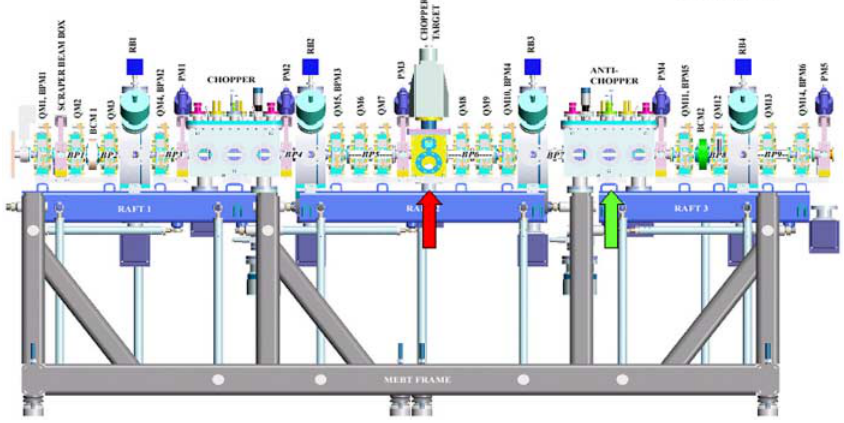
FIG. 9. (Color) Schematic layout of the MEBT indicating the location of adjustable horizontal collimators at the chopper target (red arrow). A second 4-jaw adjustable collimator could replace the antichopper as a backup (green arrow).